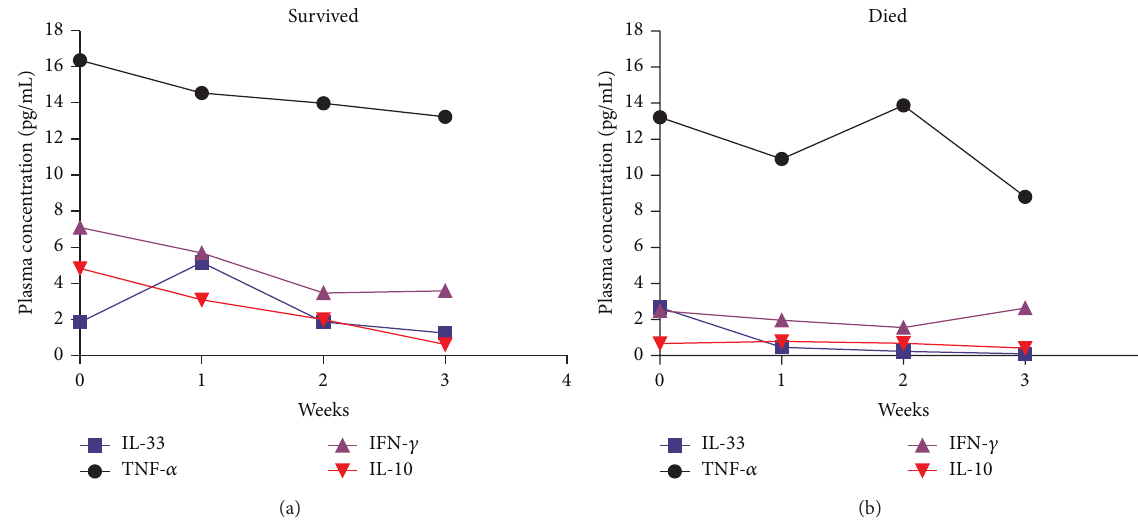
Figure 5: The dynamic process of cytokines in (a) patients who survived during the 180-day follow-up ( 𝑛 = 35 ) and (b) those who died ( 𝑛 = 13 ). Plasma levels of IL-33, TNF- 𝛼 , IFN- 𝛾 , and IL-10 were simultaneously determined by Luminex xMAP. Data are expressed as mean values; 95% confidence intervals are not shown in the figure for reasons of clarity.